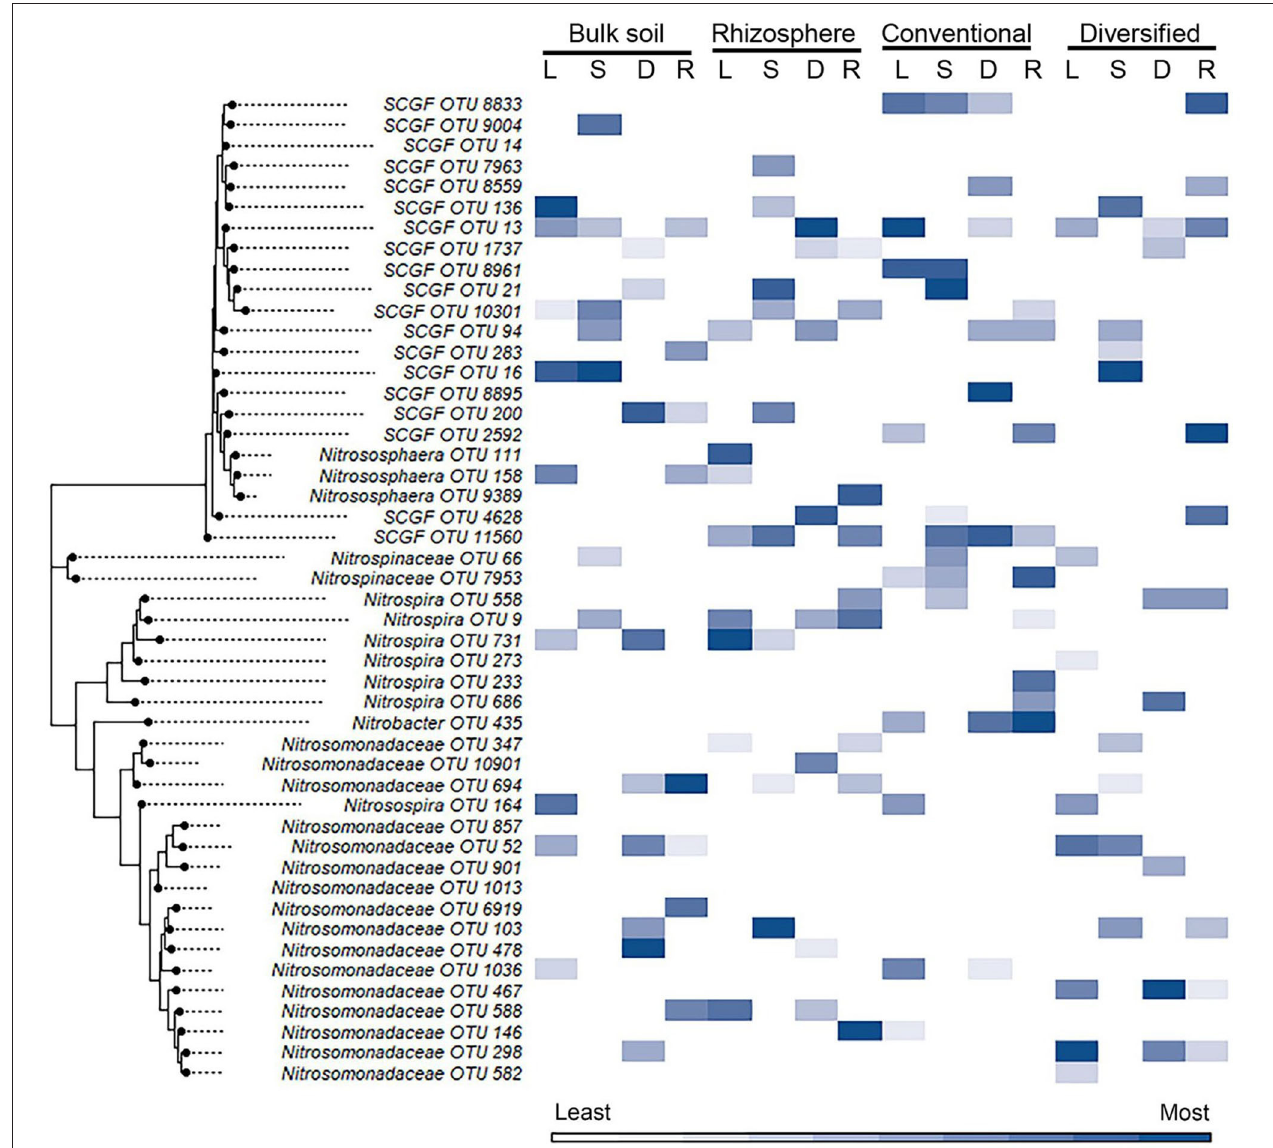
FIGURE 6 | Heat map of importance of specific OTU’s in linear and nonlinear models examining habitat and cropping system. OTU 16S V4 sequences were aligned using ClustalW in MEGA11, and the trees were generated using the maximum likelihood method with default parameters. Heat map color (within a column) reflects importance of the top 10 OTUs: white reflects OTUs ranked 10th or below in model importance (linear regression: L; support vector machine: S; decision tree: D; random forest: R). SCGF, soil crenarchaeotic group